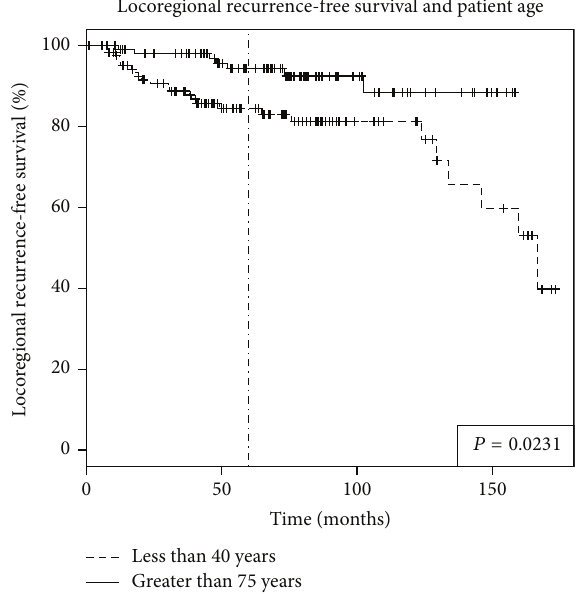
Figure 2: Distant recurrence-free survival (DRFS) in breast cancer patients based on patient age. Women younger than age of 40 had a significantly worse DRFS than those above the age of 75. The 5-year rate of DRFS was 83.1% versus 95.5% ( 𝑃 = 0.0034